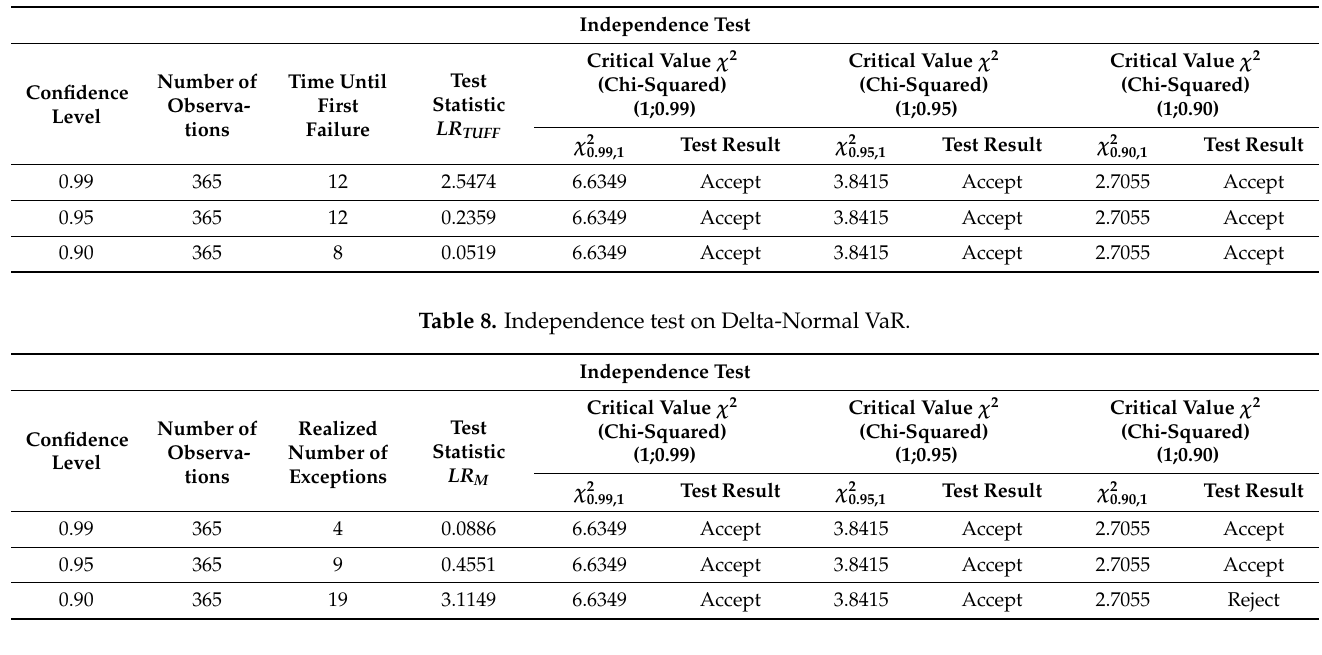
Table 7. Delta-Normal VaR Kupiec’s TUFF-test.